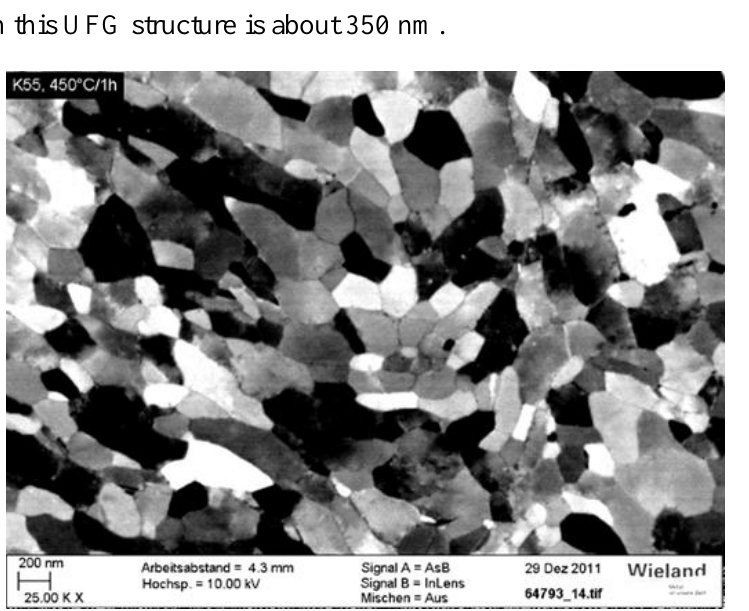
Figure 9. ECCI-picture of ultra-fine grained CuNi3Si1MgSi (swaged and aged at 450 °C/1 h, swaging from diameter of 5.3 to 2.7